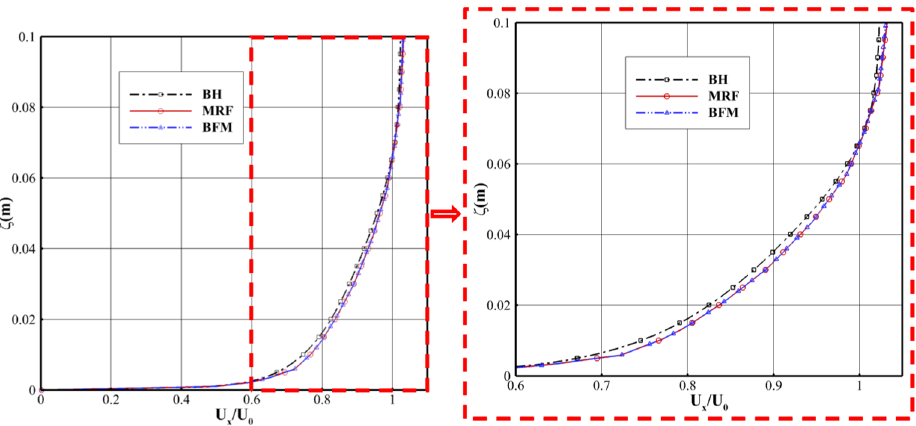
Figure 15. Velocity profiles of boundary layer at waterjet centerline of the bare hull (BH), MRF model and body-force model (BFM). ζ is the vertical distance from ship bottom plating. Table 5. Calculation (cid:4666)1 − 𝑤 ) and 𝐶 (cid:3040) of the capture area with the MRF model and body-force model.